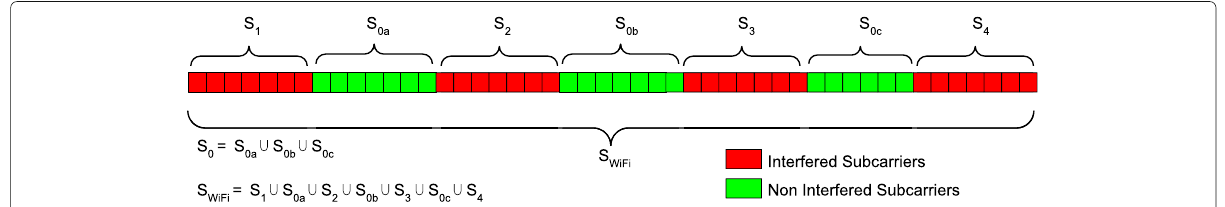
Fig. 4 Set of interfered and interference-free WiFi subcarriers facing interference by four co-channel ZigBee interferers